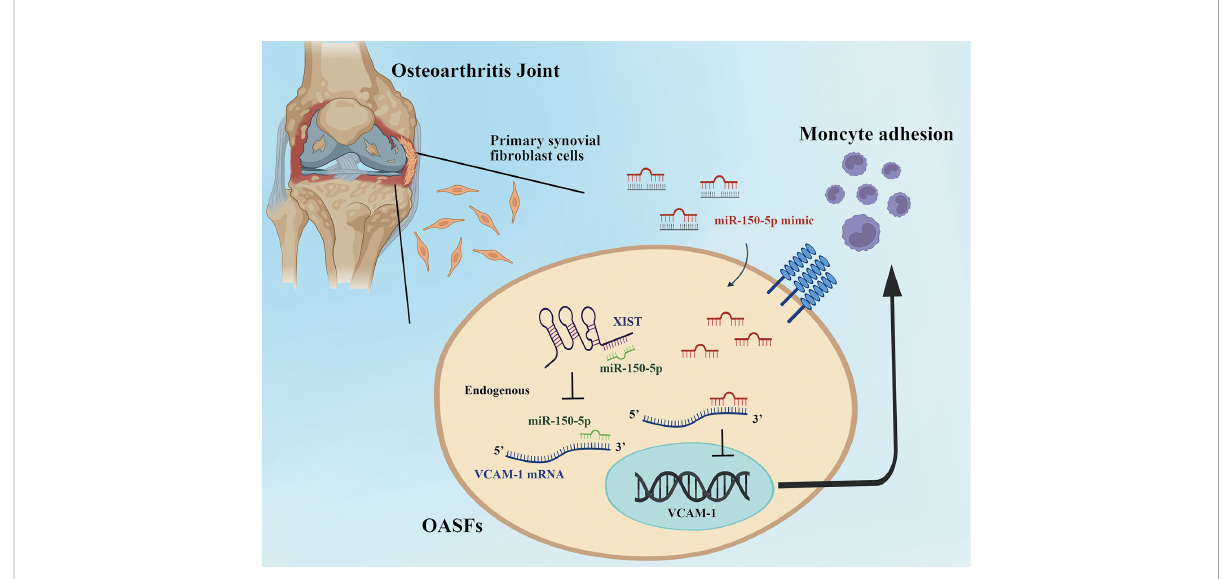
FIGURE 8 The schematic diagram summarizes the miR-150-5p and XIST interaction controls monocyte adherence in OASFs. Upregulation of miR-150-5p interferes with XIST regulation and thereby enhances VCAM-1-dependent monocyte adherence to